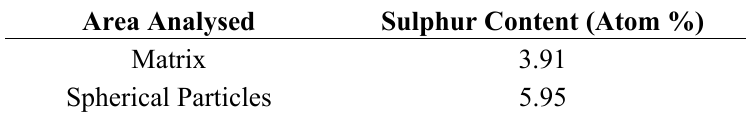
Table 4. Elemental analysis of a composite membrane containing 15% HPSU by SEM EDX.